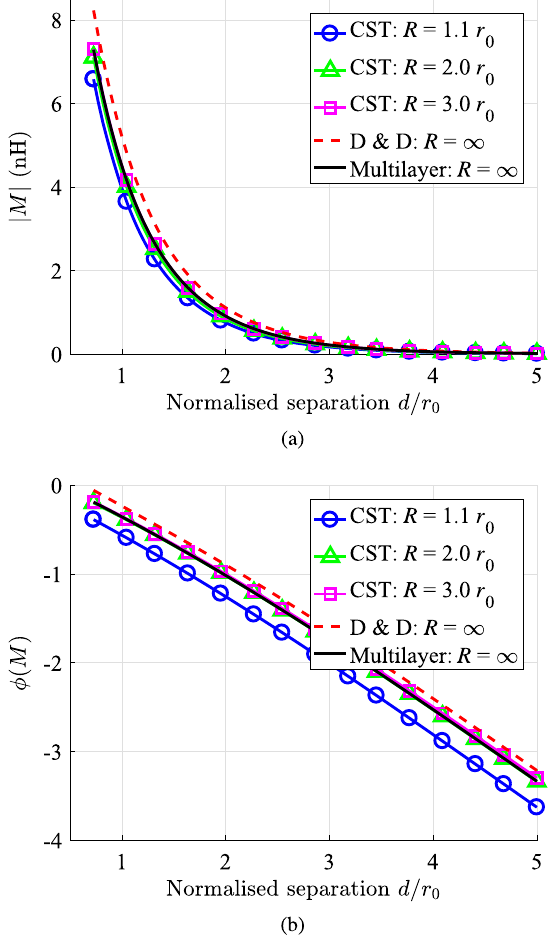
Fig. 5. Mutual inductance ( M ) of two coaxial circular coils of radius of r 0 =11 mm inside a conductive medium with con- ductivity of s = 10S/m as a function of normalised vertical separation d / r 0 . (a) Modulus and (b) phase of M obtained by the multilayer solution are compared with D&D solutions [21] and CST MWS simulation results for three different sizes of the insulating boxes.